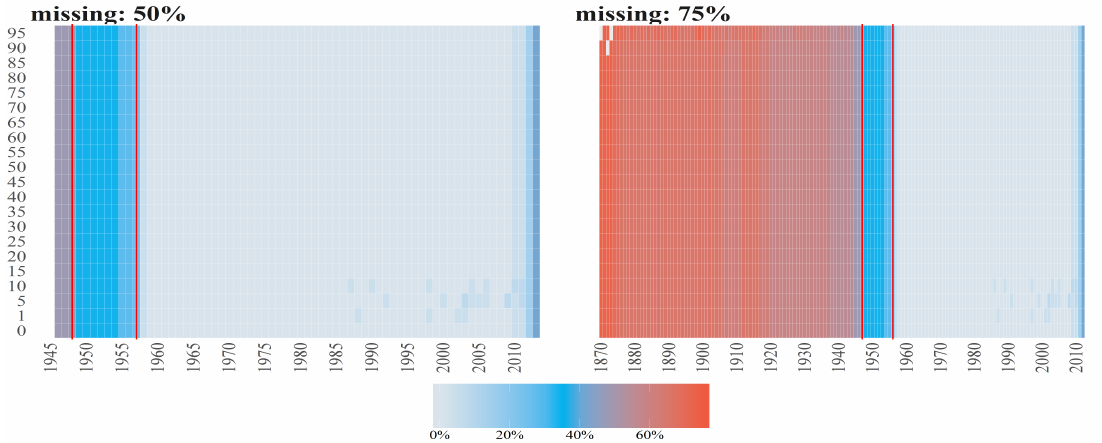
Figure 4. Percentages of missing values (denoted by diffrent colours) per observation for Number of Deaths for Males per age groups (y axis) over time (x axis). The titles of the subplots indicate the case of missing values (50%, 75%). The percentage for a given country and given age group is computed dividing number of missing values by number of countries. Red vertical lines correspond to the starting points in time when the cases 50% and 25% starts (from the left to right side on corresponding plots).